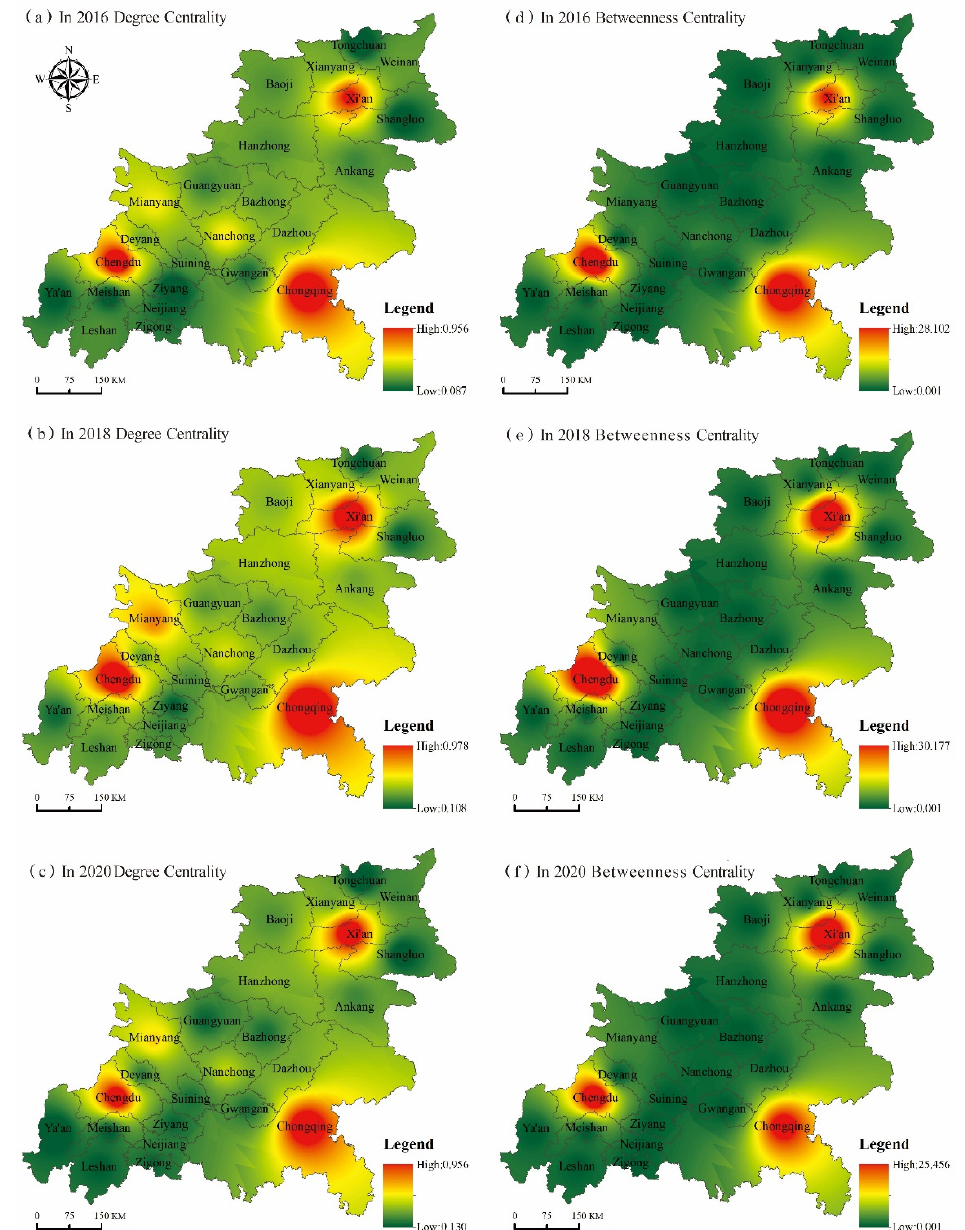
Figure 2. Centrality of cultural tourism network attention in WTEZ: ( a ) degree centrality in 2016; ( b ) degree centrality in 2018; ( c ) degree centrality in 2020; ( d ) betweenness centrality in 2016; ( e ) betweenness centrality in 2018; ( f ) betweenness centrality in 2020.